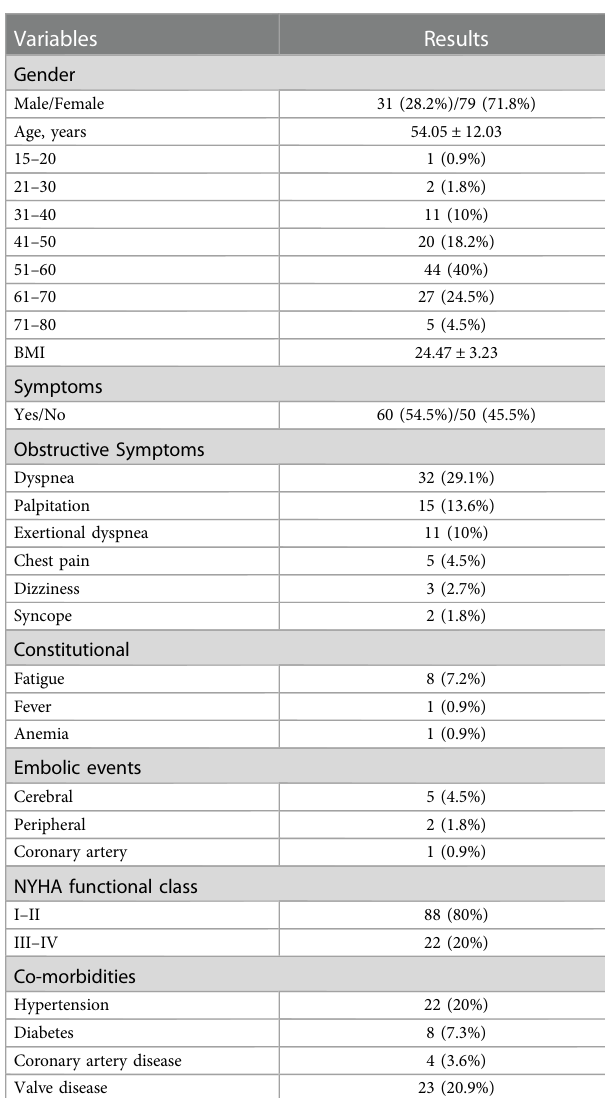
TABLE 1 Patient characteristic ( n =110). TABLE 2 Preoperative variables and examination.